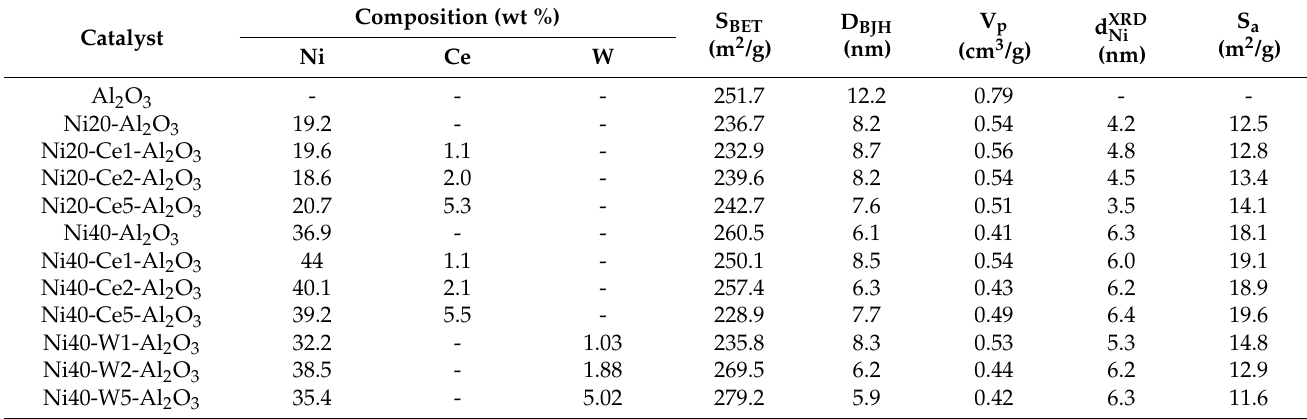
Table 1. Catalyst composition determined by the XRF method, specific surface area (S BET ), mean pore diameter (D BJH ), and total pore volume (V p ) of support and catalysts determined after calcination. Mean nickel crystallite size estimated form the XRD data (d XRD Ni ), an active surface area of